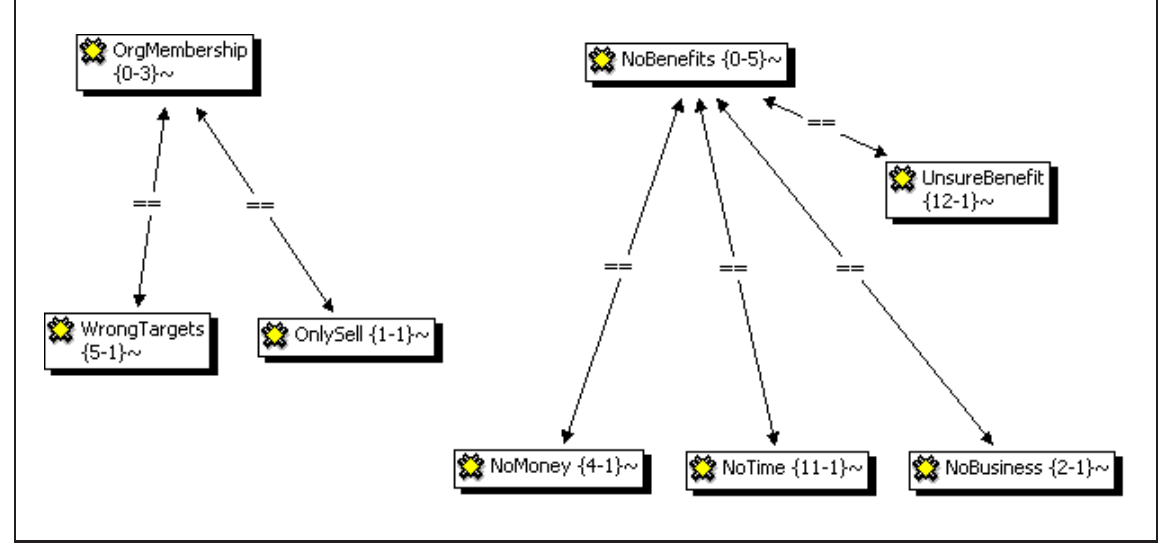
Figure 1. Patterns and Descriptors of Negative Comments